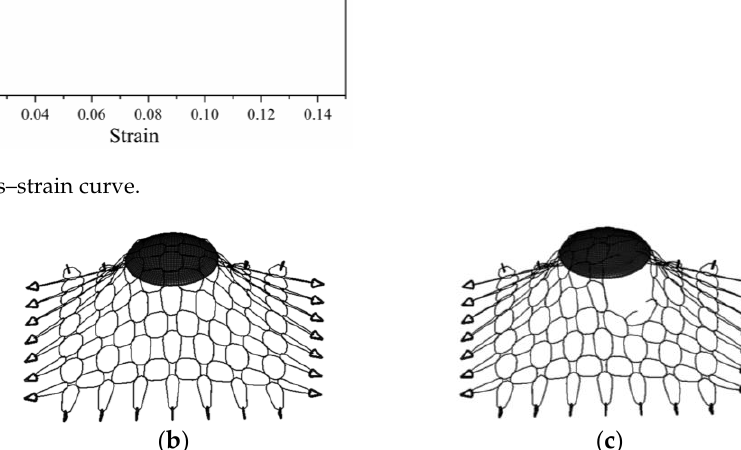
Figure 10. Stress – strain curve.